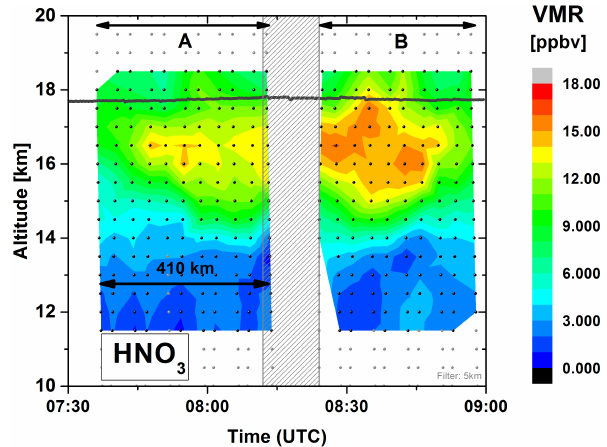
Figure 10. Vertical cross section of gas-phase HNO 3 retrieved from the MIPAS-STR observations associated with the flight on 30 Jan- uary 2010. Compare Fig. 6 (from Woiwode PhD thesis, 2013, with